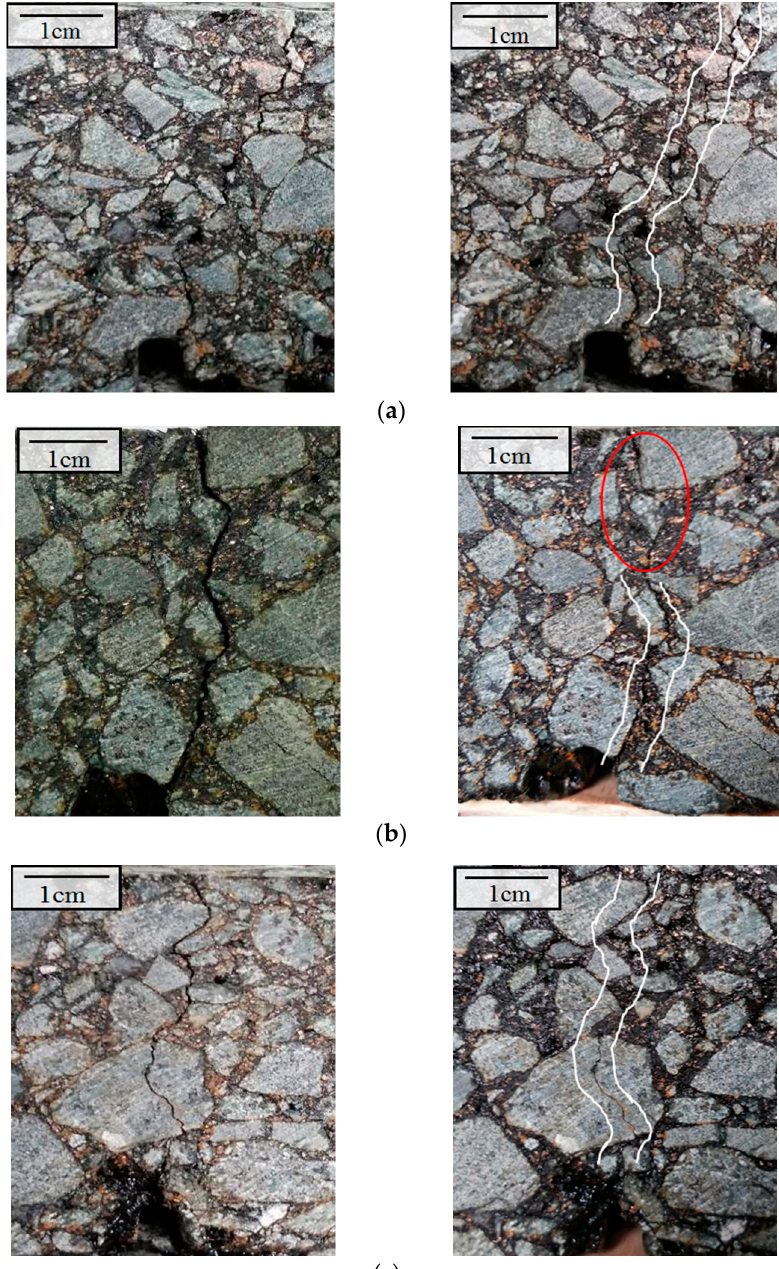
Figure 7. Healing phenomenon at different temperatures under induction heating. ( a ) Crack healing phenomenon at 60 °C: crack not healed; ( b ) Crack healing phenomenon at 80 °C: crack partially healed; ( c ) Crack healing phenomenon at 100 °C: fully healed, except for broken stone.